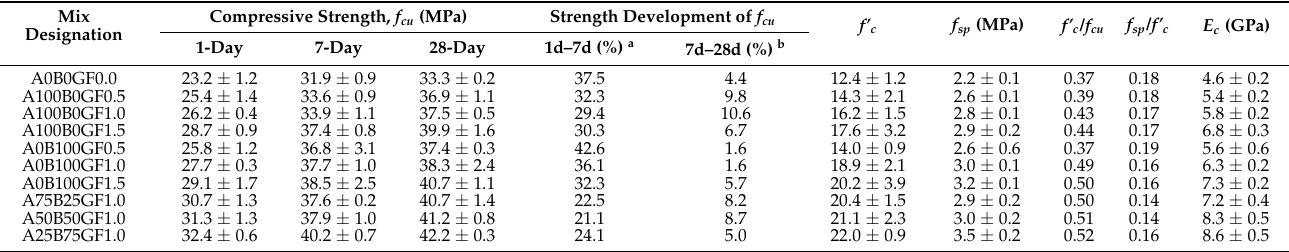
Table 7. Results of compressive and tensile strengths and modulus of